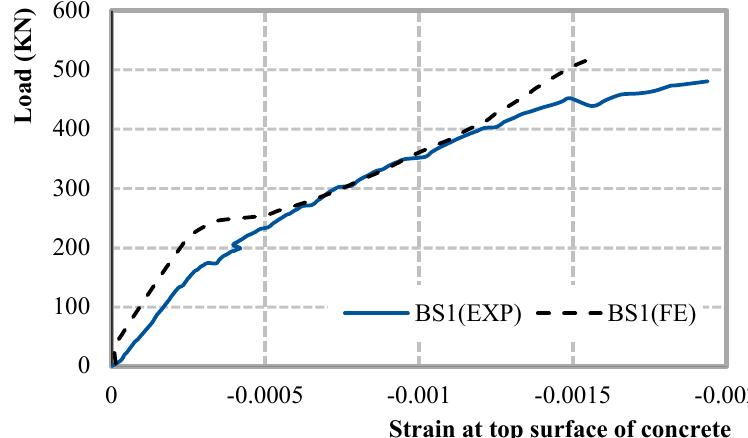
Figure 28. Comparison between EXP and FEM for the concrete strain of BS1 slab.